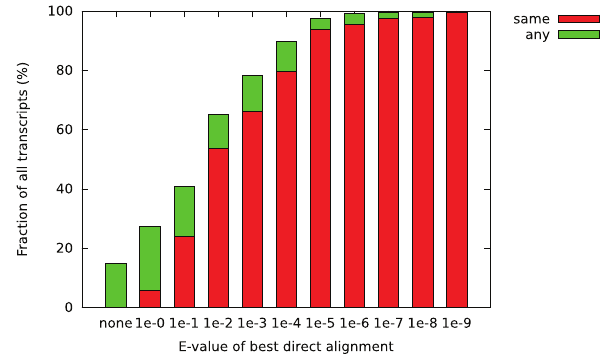
Figure 5. The fraction of all transcripts receiving an annotation using transitive alignment, grouped by e-value threshold of the transcript’s best SwissProt match. Red bars indicate that the gene symbol of the best SwissProt match is also among the transitive annotations (see also Fig. 6), green bars that only different proteins were matched.